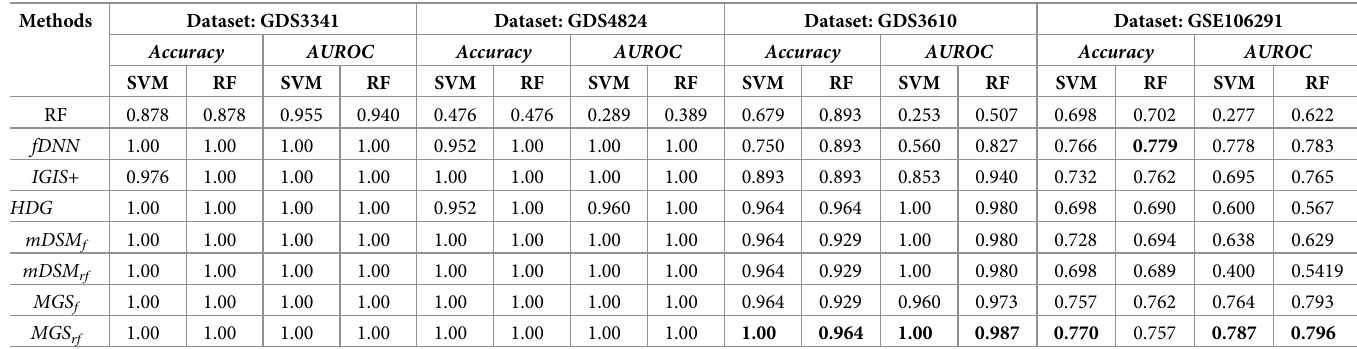
Table 4. Classification accuracy and AUROC of different methods for imbalanced datasets. Methods Dataset: